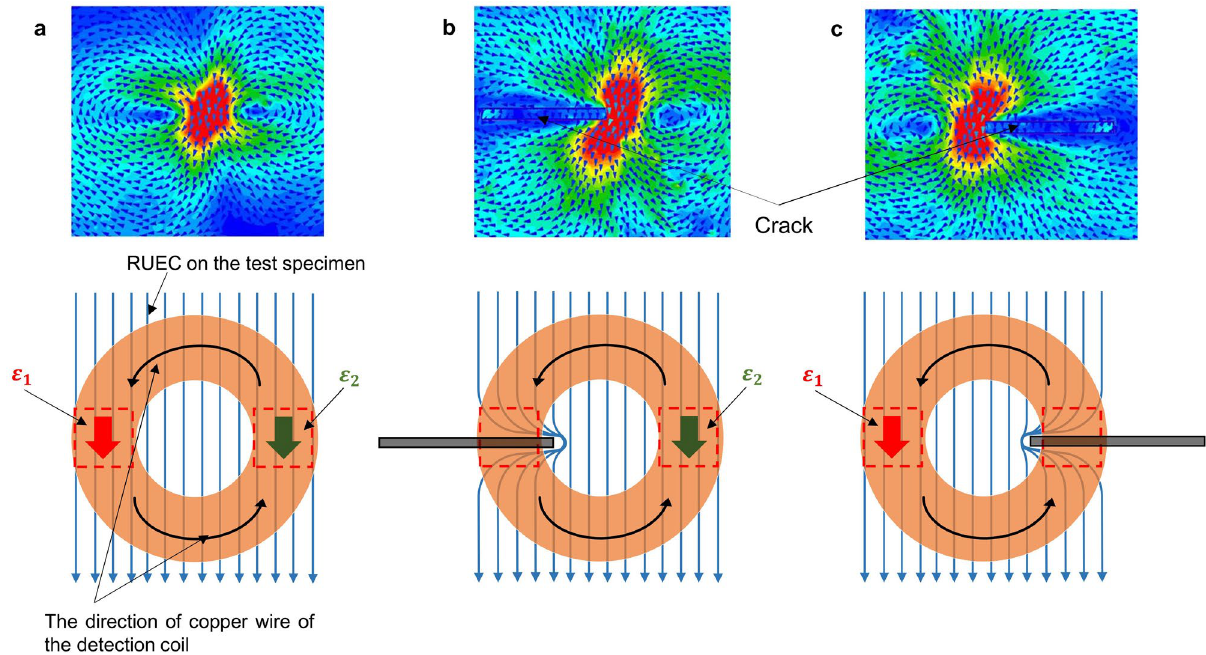
Figure 6. Principle of the output detection signal with the circular detection coil. ( a ) Without a crack. ( b ) With a crack under the left side of the detection coil. ( c ) With a crack under the right side of the detection